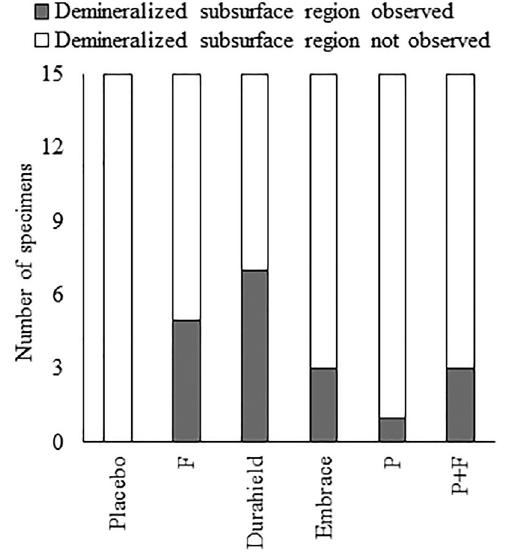
Figure 5- Number of specimens with subsurface demineralized regions in the